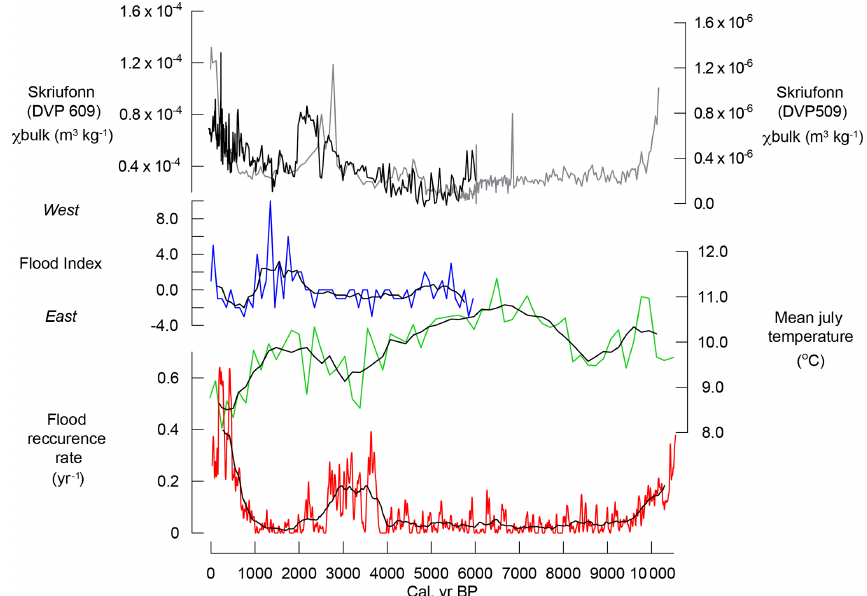
Figure 18. Flood frequency in Glomma (red) with a 500-year running average, reconstructed summer temperature from Brurskardtjørni, southern Norway (Velle et al., 2010) (green) with a five-point running average, and flood index (blue) with a five-point running average (Støren et al., 2012) showing the relative distribution of the flood recurrence rate over southern Norway. Glacier activity at Skriufonn, Rondane, southern Norway (Kvisvik et al., 2015) (black and